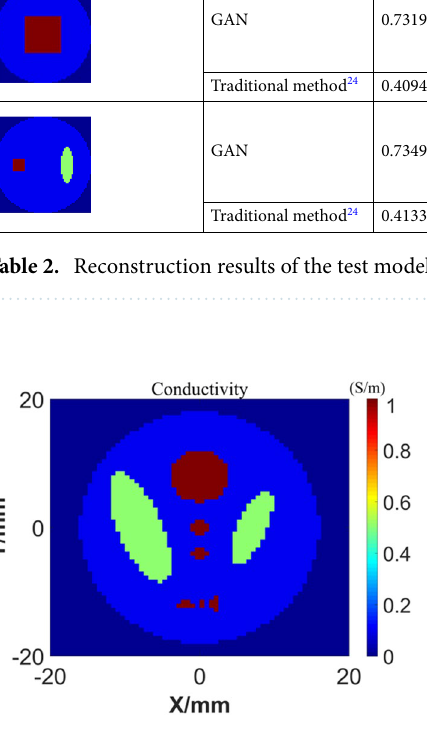
Figure 9. Conductivity distribution of the models.